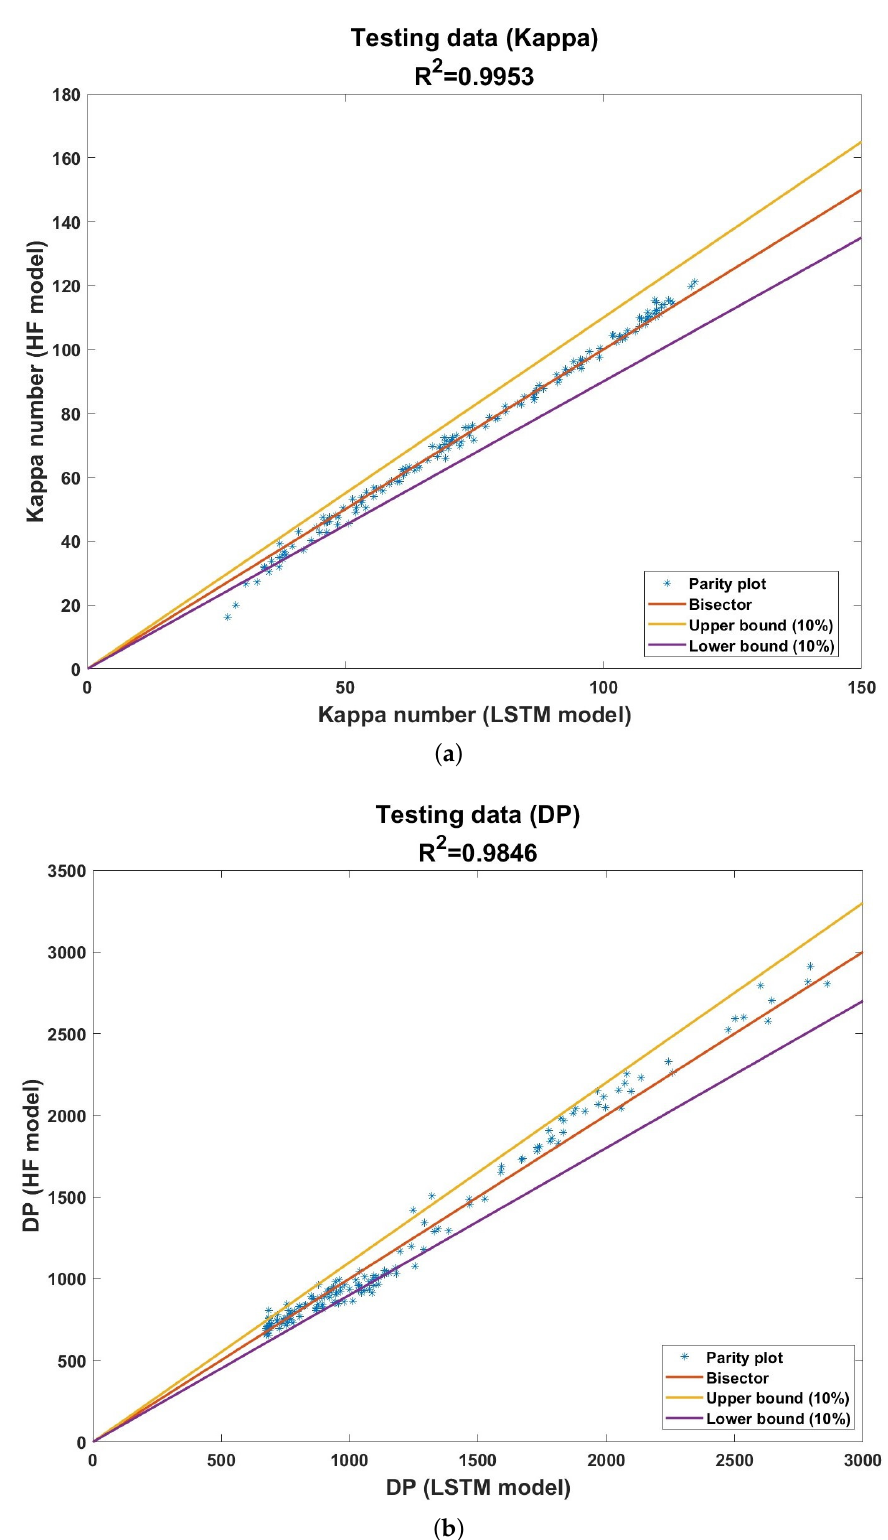
Figure 6. ( a ) Parity plot for the Kappa number prediction for the test data (100 datasets) at the end of the pulping process t = t end with the LSTM-ANN model and ( b ) parity plot for DP prediction for the test data (100 datasets) at the end of the pulping process t = t end with the LSTM-ANN